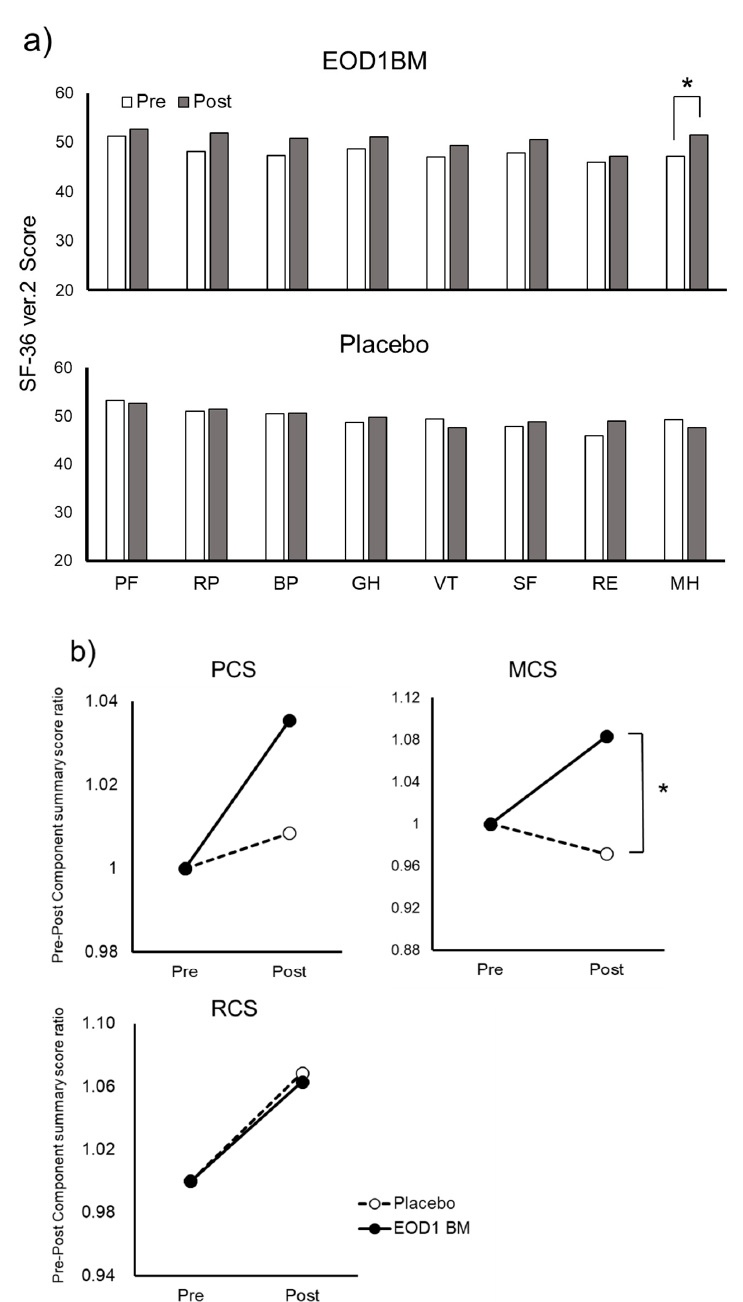
Figure 8. Effect of ingestion of Euglena gracilis EOD-1 biomass (EOD1BM) on health-related quality of life (QOL). ( a ) Influence of EOD1BM ingestion on the scores of the subscales of Medical Outcomes Study 36-Item Short Form version 2 (SF-36v2) ( n = 7). A questionnaire survey from SF-36v2 was administered to the subjects after approximately 4 weeks of EOD1BM ingestion ( n = 7). The scores